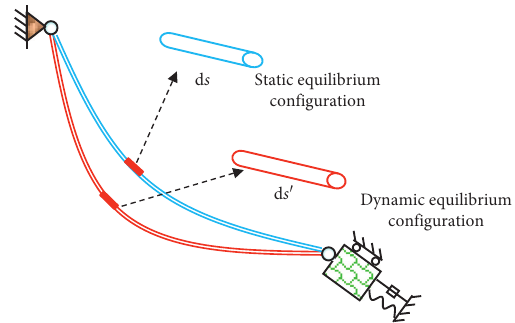
Figure 2: Microelement diagram of